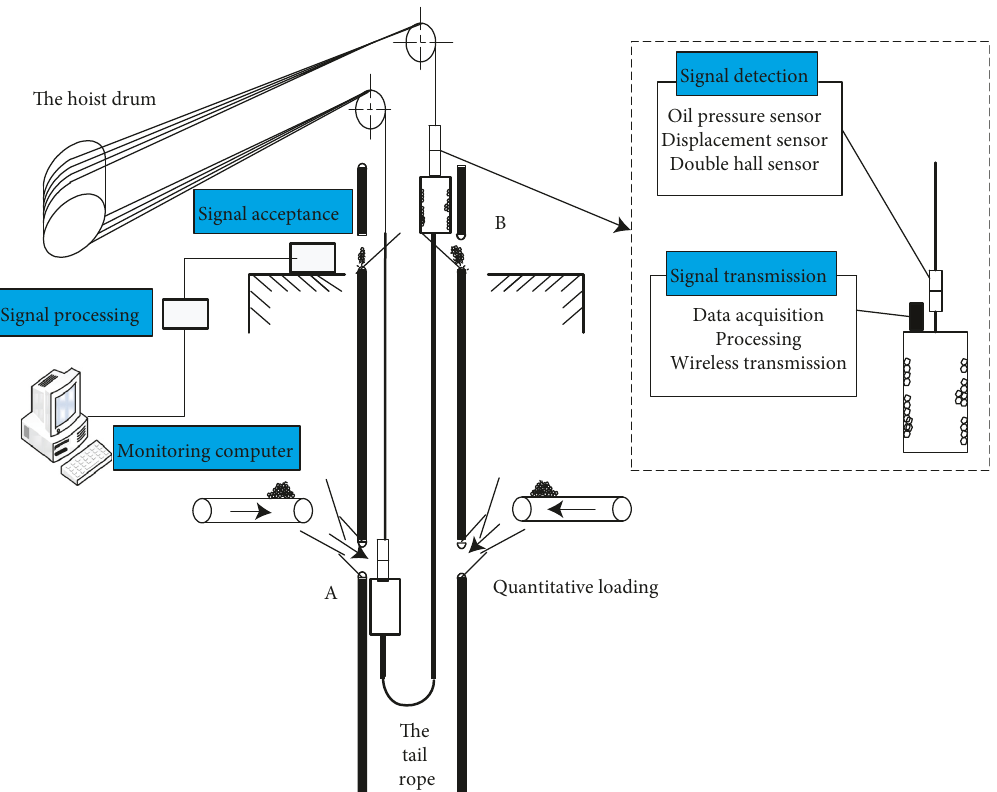
Figure 20: Monitoring system structure of wire rope tension and